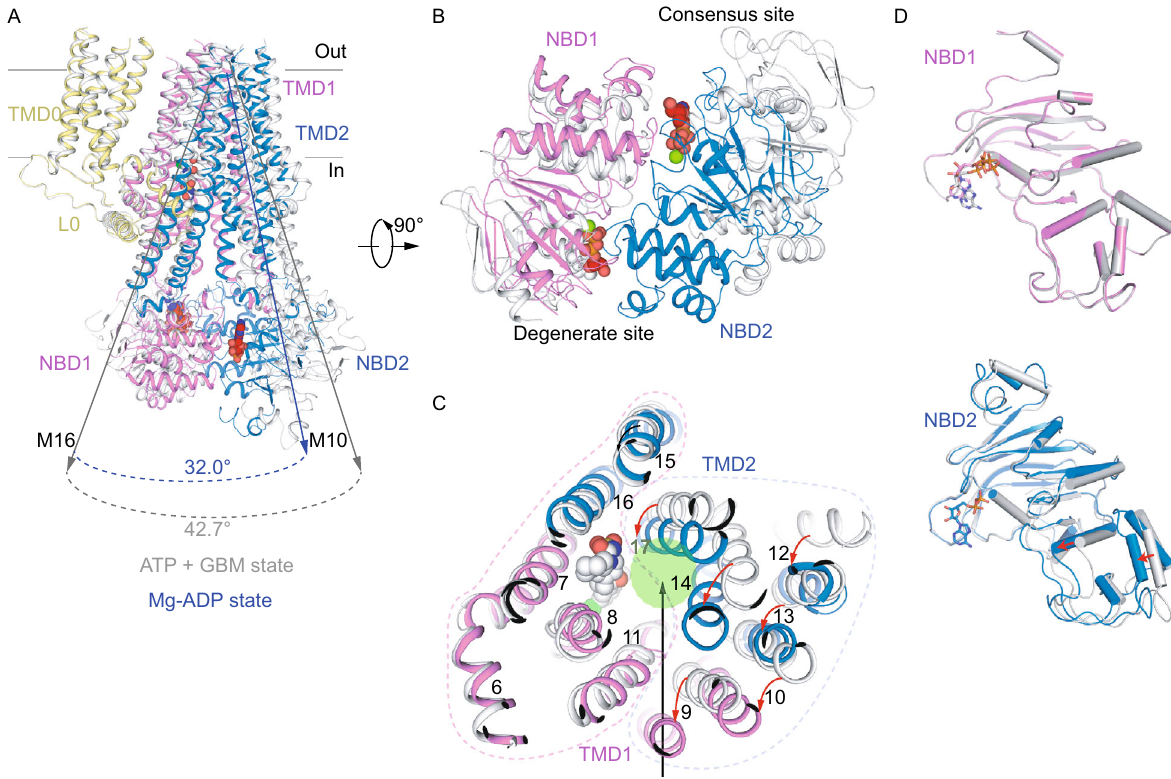
Figure 5. Conformational changes of SUR1. (A) Superposition of the Mg-ADP bound structure (colored) and the ATP + GBM bound structure (gray) by aligning the TMD0 domain of SUR1. Angles between helices M10 and M16 in the two structures are labeled. Mg-ADP, ATP γ S and GBM molecules are all shown as spheres. (B) Bottom view of NBDs of the K ATP channel with a 90° rotation relative to (A). (C) Bottom view of TMDs of the K ATP channel with a 90° rotation relative to (A). Positional changes of transmembrane helices from the fi rst half of TMDs (M9 – 10, 12 – 14 and 17) are indicated by red arrows. The dashed lines specify the two halves of TMDs. The putative KNtp binding site is shown as a green circle, showing the displacement of GBM-binding sites upon nucleotide binding. (D) Structural comparisons of individual NBD1 (top) or NBD2 (bottom) between the ATP + GBM state (gray) and the Mg-ADP state (colored). Conformational changes of α helices-rich subdomain in NBD2 are indicated by red arrows. NBD structures are aligned according to β sheet-rich